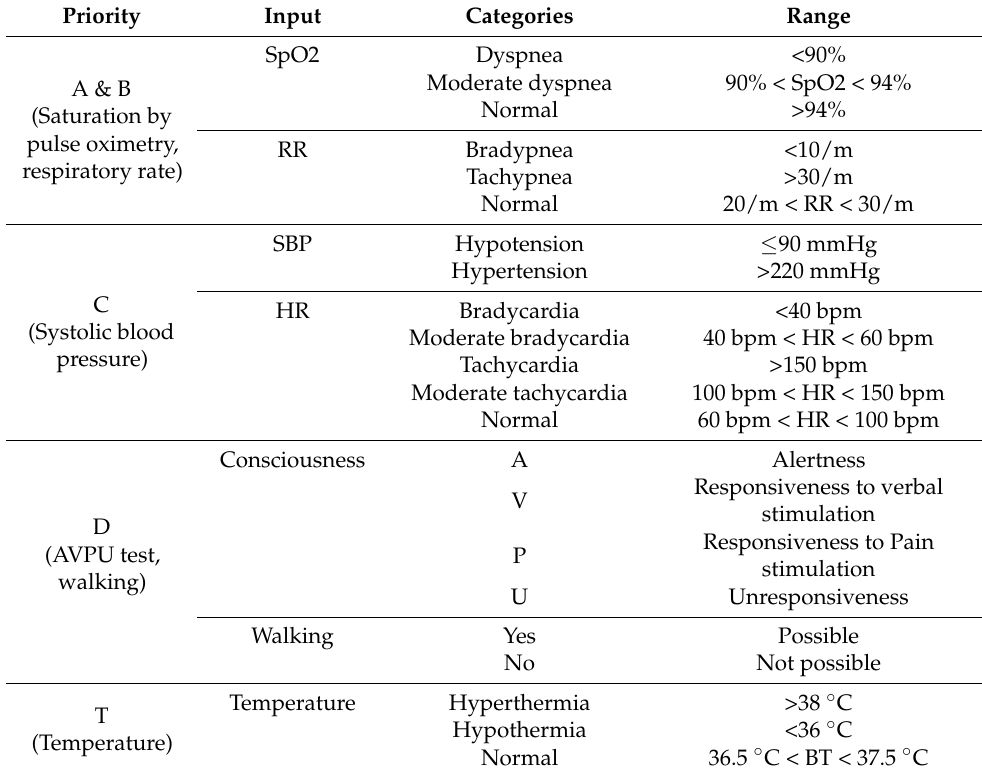
Table 2. Algorithm of e-triage tag